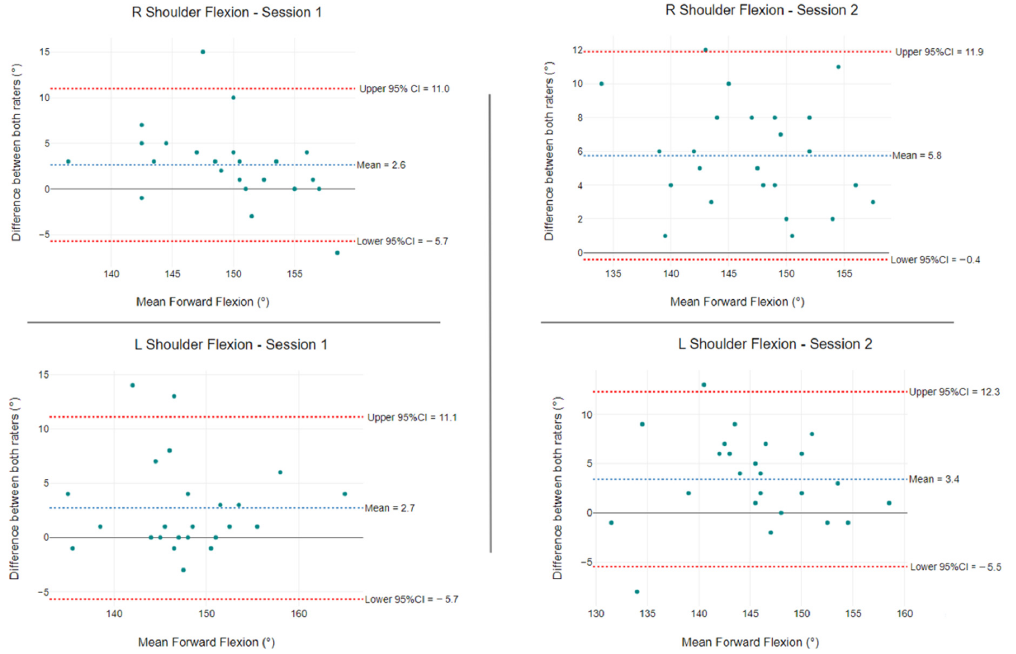
Figure 5. Shoulder flexion ROM differences between raters for left and right sides (n = 24). The blue segmented line is the mean difference between raters, and the segmented red lines show the 95% LoA.